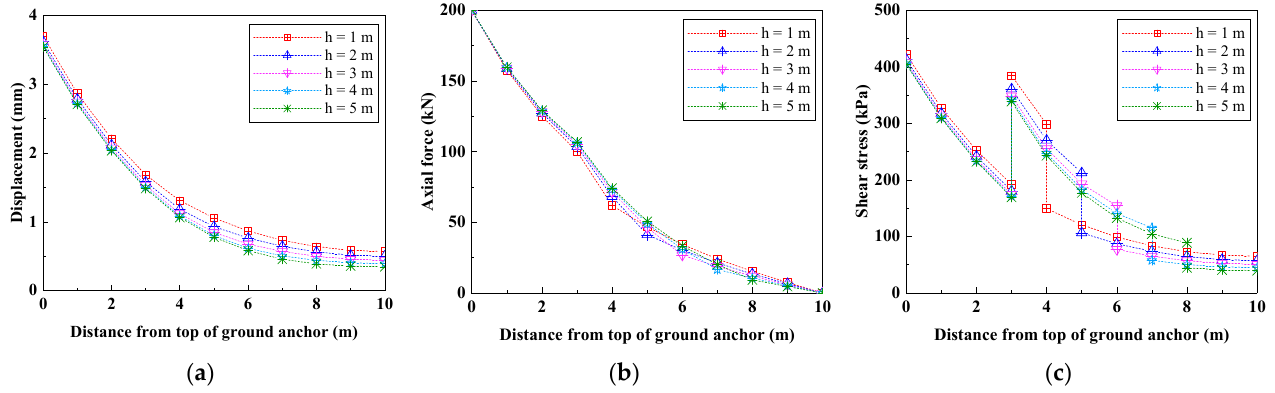
Figure 11. Effect of interlayer thickness change on mechanical behavior of ground anchor. (Case 2: condition 2) ( a ) displacement distribution curve; ( b ) axial force distribution curve; ( c ) shear stress distribution curve.